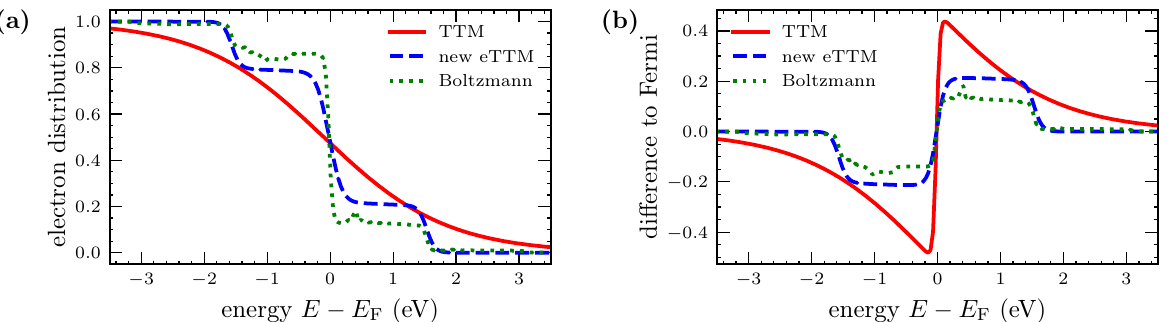
Figure 5. Electron distribution directly after a pulse with a δ -peaked shape. Figure ( a ) shows the distributions with a TTM simulation, an eTTM simulation and a simulation using the Boltzmann collision term for the electron–ion–photon interaction for the same absorbed energy density. The TTM results in a Fermi distribution with elevated temperature. In contrast, the distribution obtained from the eTTM shows two steps, indicating the non-equilibrium. The eTTM and the Boltzmann simulation result in similar distributions. In Figure ( b ), the difference to the initial distribution is shown. The difference between the TTM and the eTTM is